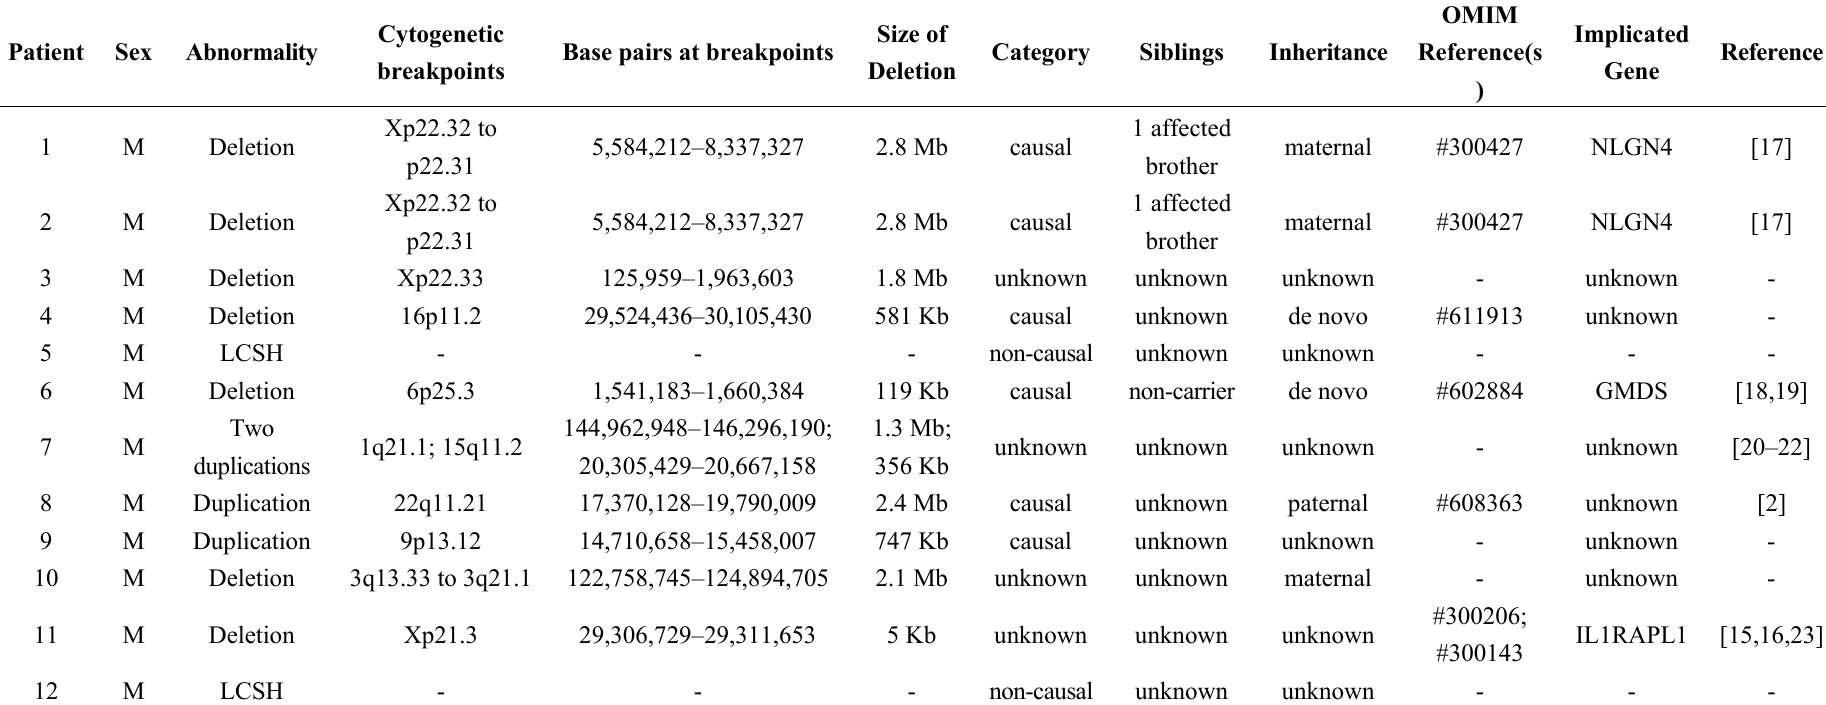
Table 2. Characteristics of the 13 patients with an abnormal chromosomal